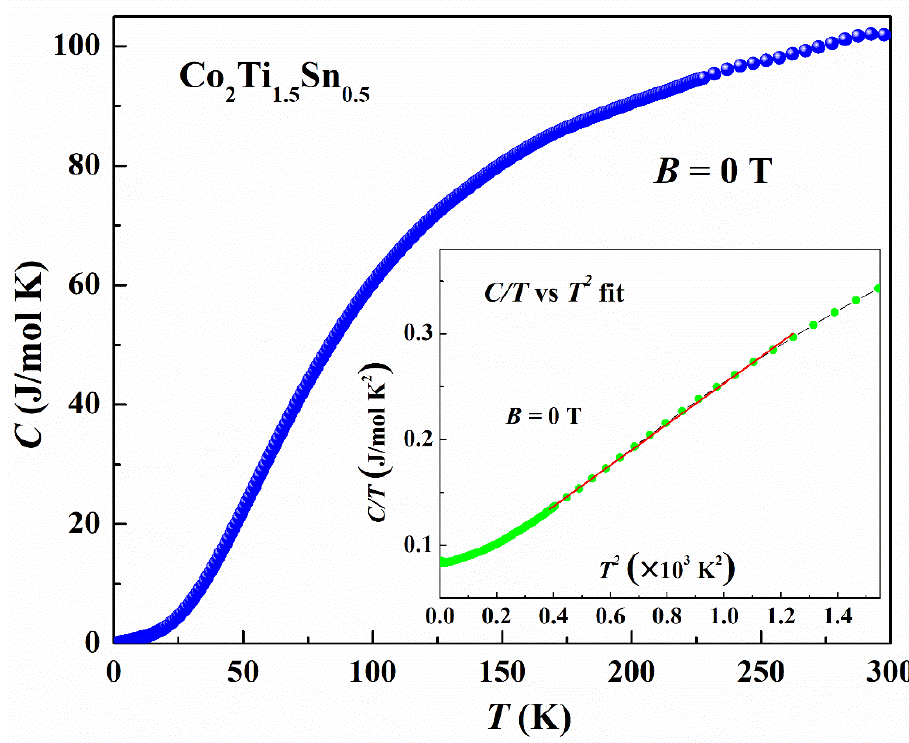
Figure 5. Variation in heat capacity C(T) in the absence of an applied magnetic field. Inset shows the least square linear fit of C / T vs. T 2 .